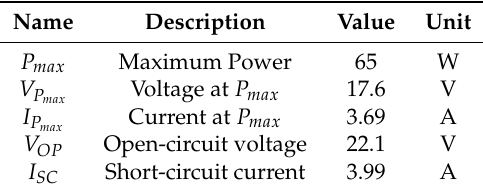
Table 3. BP365 PV panel